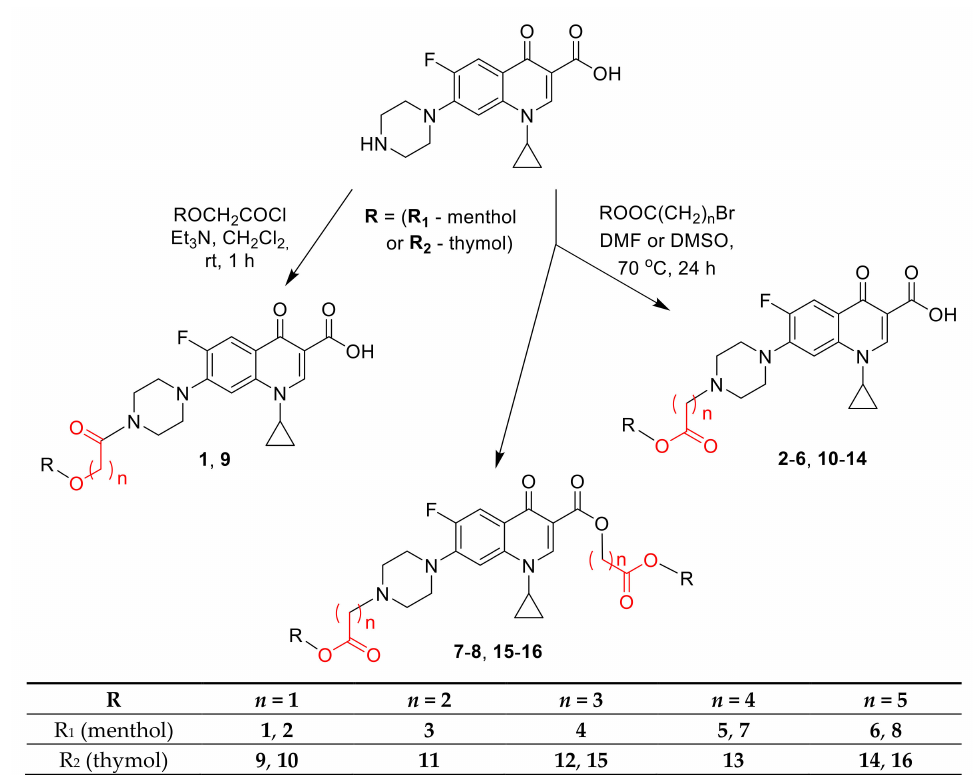
Scheme 1. Synthesis of menthol and thymol derivatives of